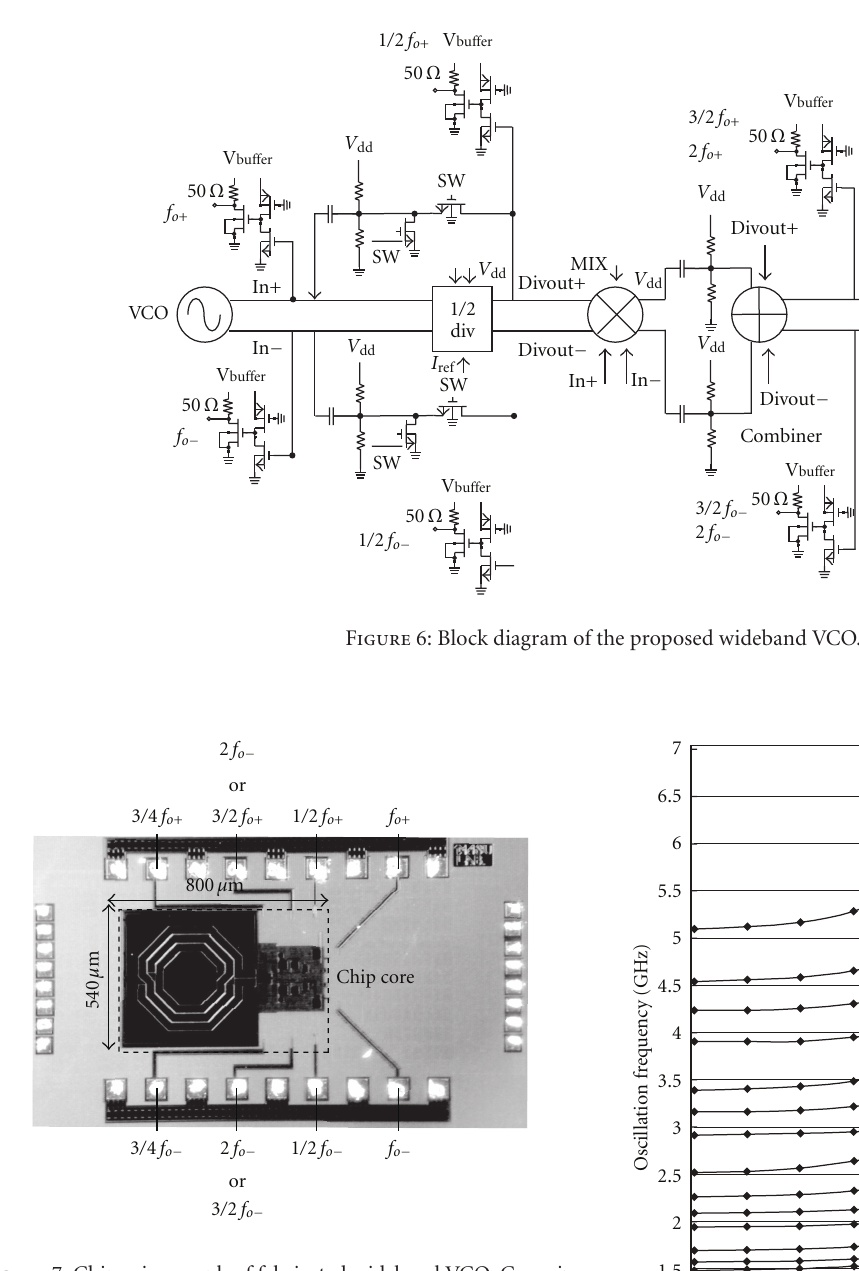
In case (B), 2 f 0 is the desired frequency and DC signal is spurious. The DC signal can be suppressed by the high-pass filter. In the proposed architecture, distance to spur is large, which is a desirable feature for spurious rejection in both cases (A) and (B). The proposed architecture is also expected to be robust for LO